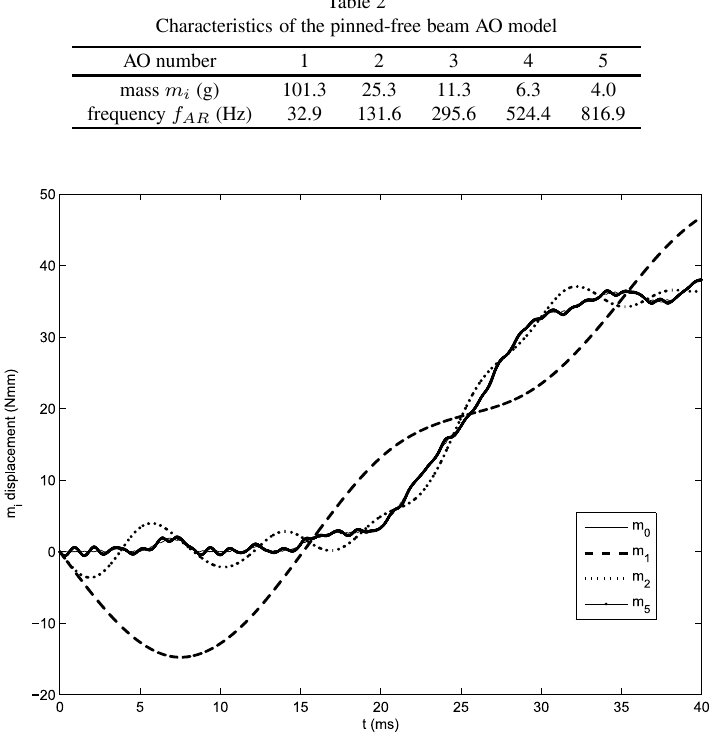
Fig. 2. m 0 , m 1 , m 2 , m 5